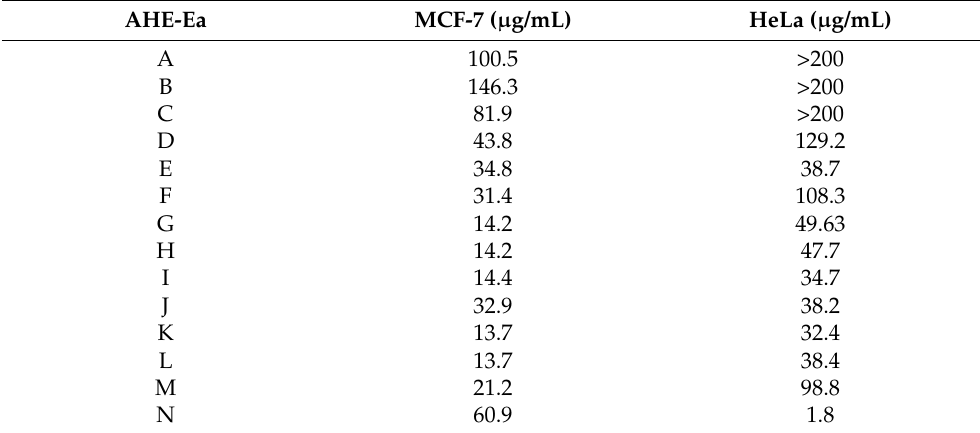
Table 1. The IC50 of the AHE-Ea subfractions in MCF-7 and HeLa cells.